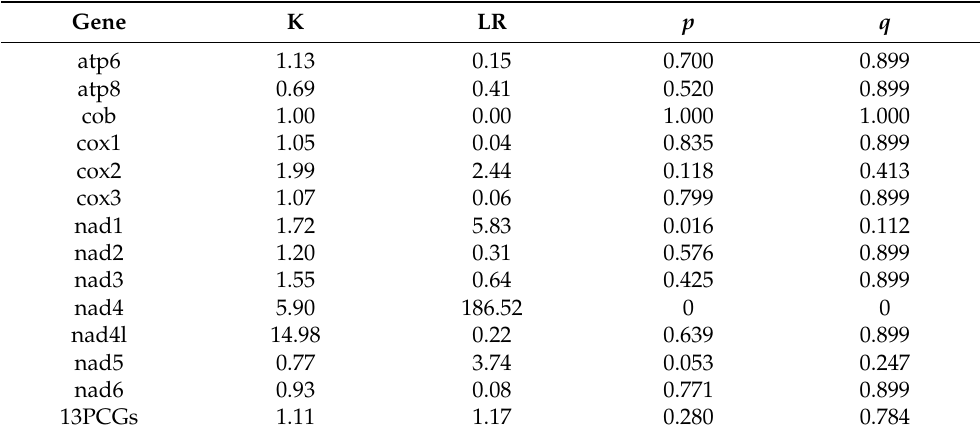
Table 2. Relaxed selection test of asexual branches, T. cacoeciae , and T. pretiosum , compared to sexual